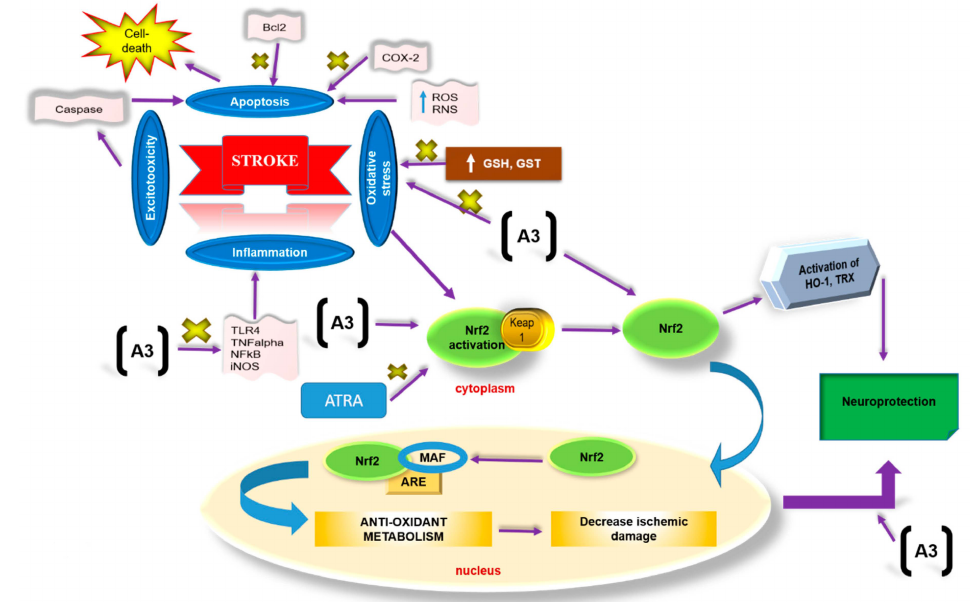
Figure 8. The graphical representation to elaborate on the possible mechanism underlying antioxidative and anti-inflammatory potential of A3 against the p-MCAO-induced brain injury. A3 causes Nrf2 activation and suppresses oxidative damage as indicated by elevated GST and GSH and reduced